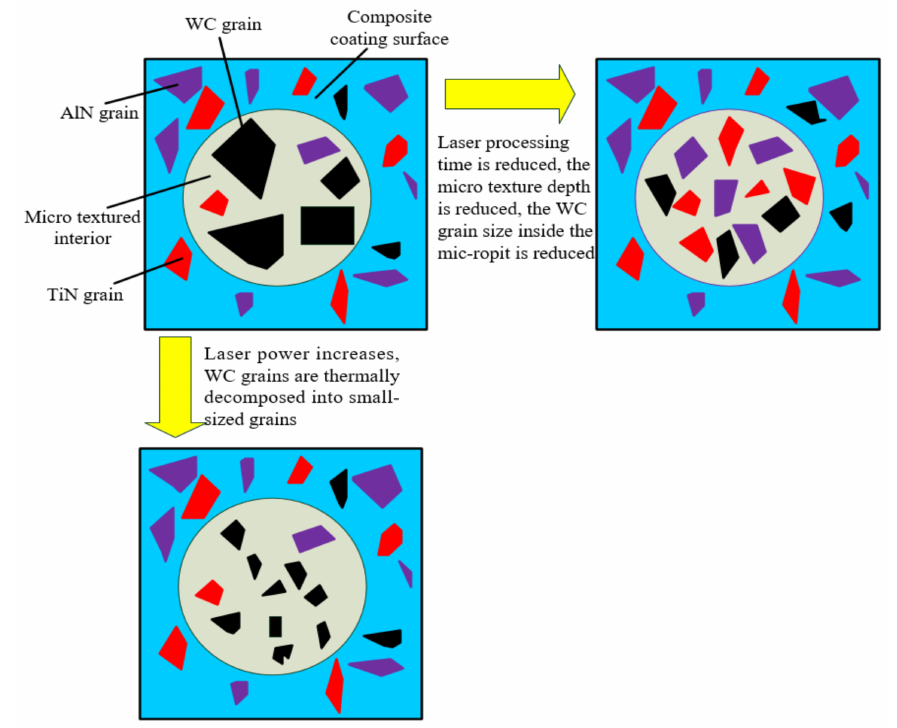
Figure 5. Changes in the WC grains resulting from laser action during the micro-texture preparation